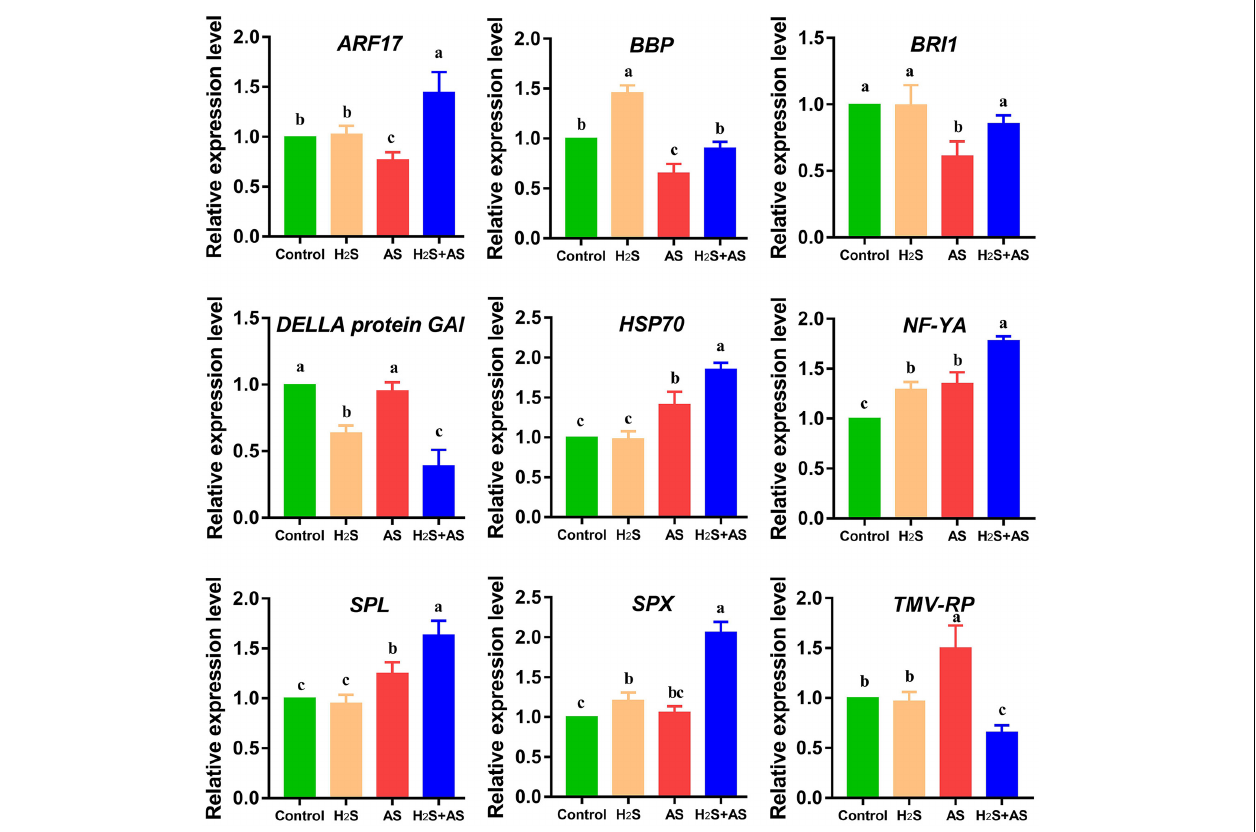
FIGURE 8 | qRT-PCR analysis of predicted target genes of differentially expressed miRNAs in M. hupehensis roots under different treatments. Three biological replicates were conducted for each sample, and three technical replicates were conducted. The relative expression level of miRNAs was calculated by 2 − (cid:49)(cid:49) CT method. The 18S rRNA was used as internal reference for normalizing gene expression. The expression levels were normalized to those of the control. The standard error (SE) values are represented by the error bar, and the significant differences ( P < 0.05) are indicated by different lowercase letters above each bar. ARF17, auxin response factor 17; BBP, basic blue protein-like; BRI1, receptor-like protein kinase BRI1-like 3; HSP70, heat shock 70 kDa protein; NF-YA, nuclear transcription factor Y subunit A-5-like; SPL, squamosa promoter-binding-like protein 18; SPX, SPX domain-containing membrane protein; TMV-RP, TMV resistance protein